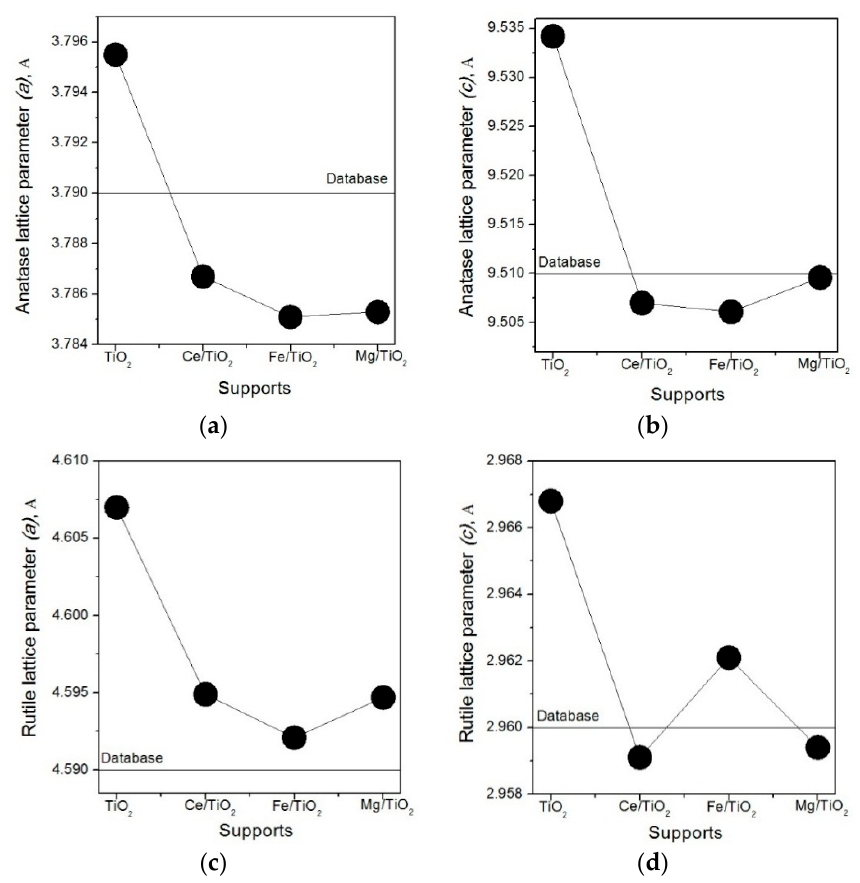
Figure 7. Lattice constants of anatase ( a , b ) and rutile ( c , d ) calculated on the basis of EXAFS data for the studied supports.